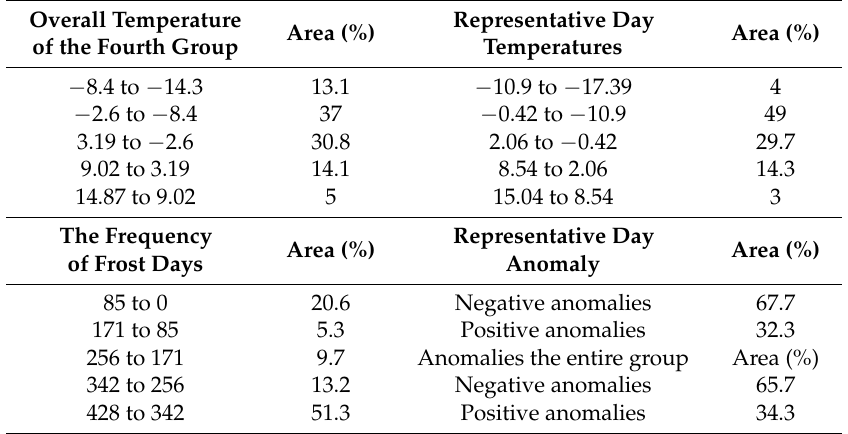
Table 5. Percentage of the covered area of different classes of average temperature, anomalies and frequency of frosts for the fourth group.